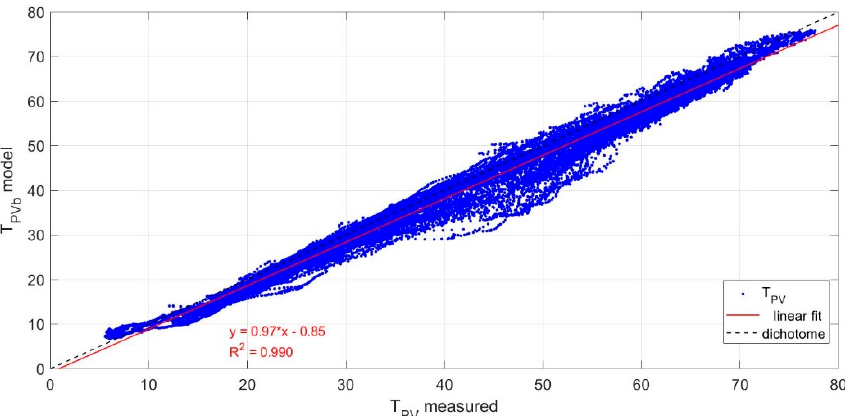
Figure 8. PV temperature predicted by the proposed dynamic model vs. measured values across the period April–May–June for the BIPV system and a wide range of environmental conditions.